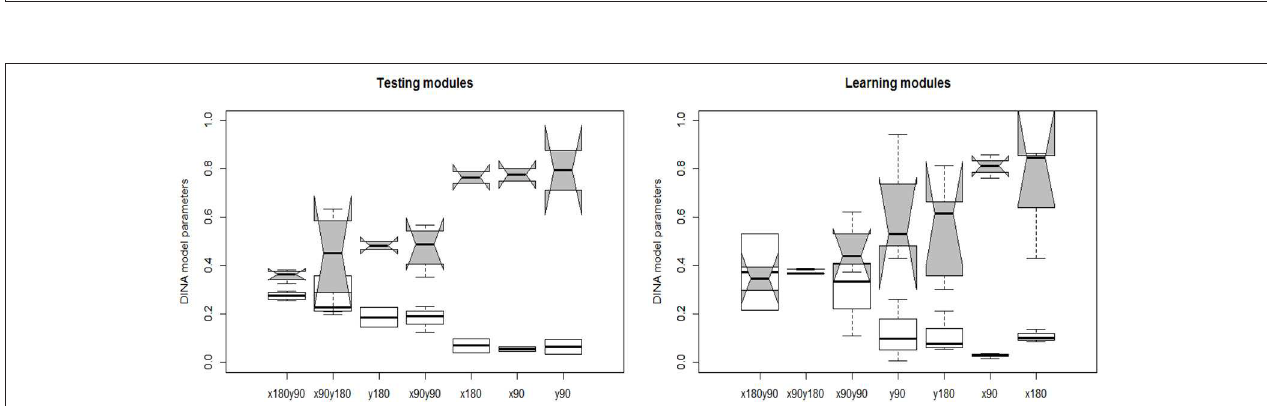
FIGURE 6 | The maximum univariate Gelman-Rubin proportional scale reduction factor from the joint model as a function of number of iterations, when uniform initial attribute patterns were used. Dotted line represents the cutoff of 1.2.